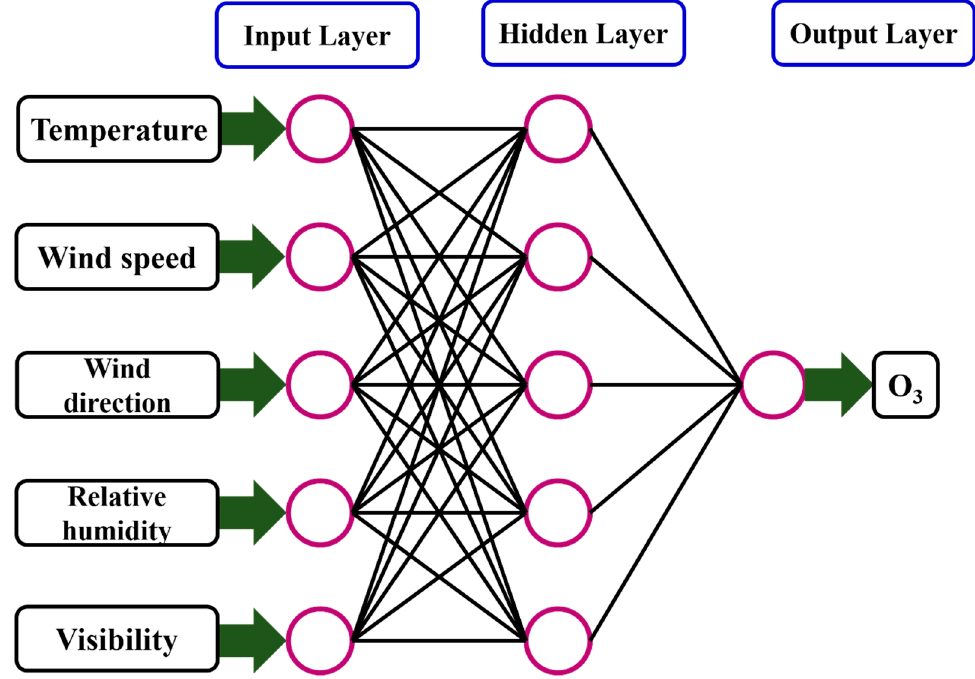
Figure 2. The framework of the ozone simulation model.